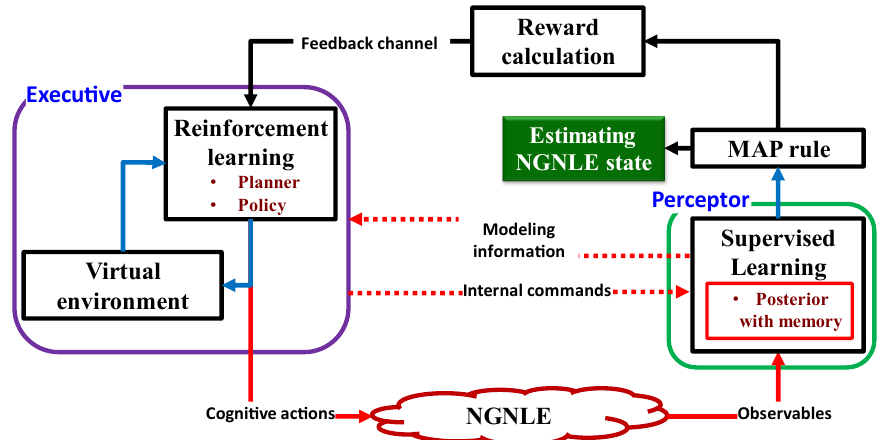
Figure 13. The proposed CDS ’ s conceptualization.